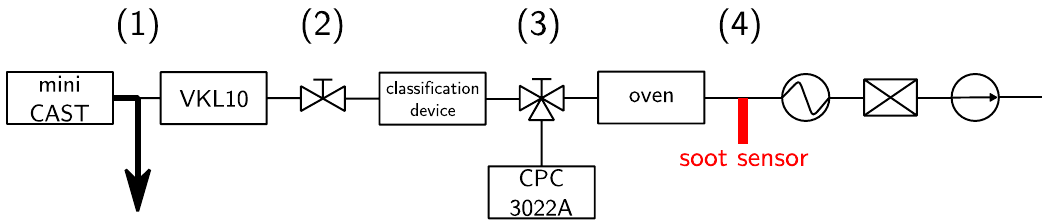
Figure 1. Schematic view of the experimental bench. A CPC 3022A, TSI (Condensation Particle Counter) has been used to measure the distribution size function of the soot